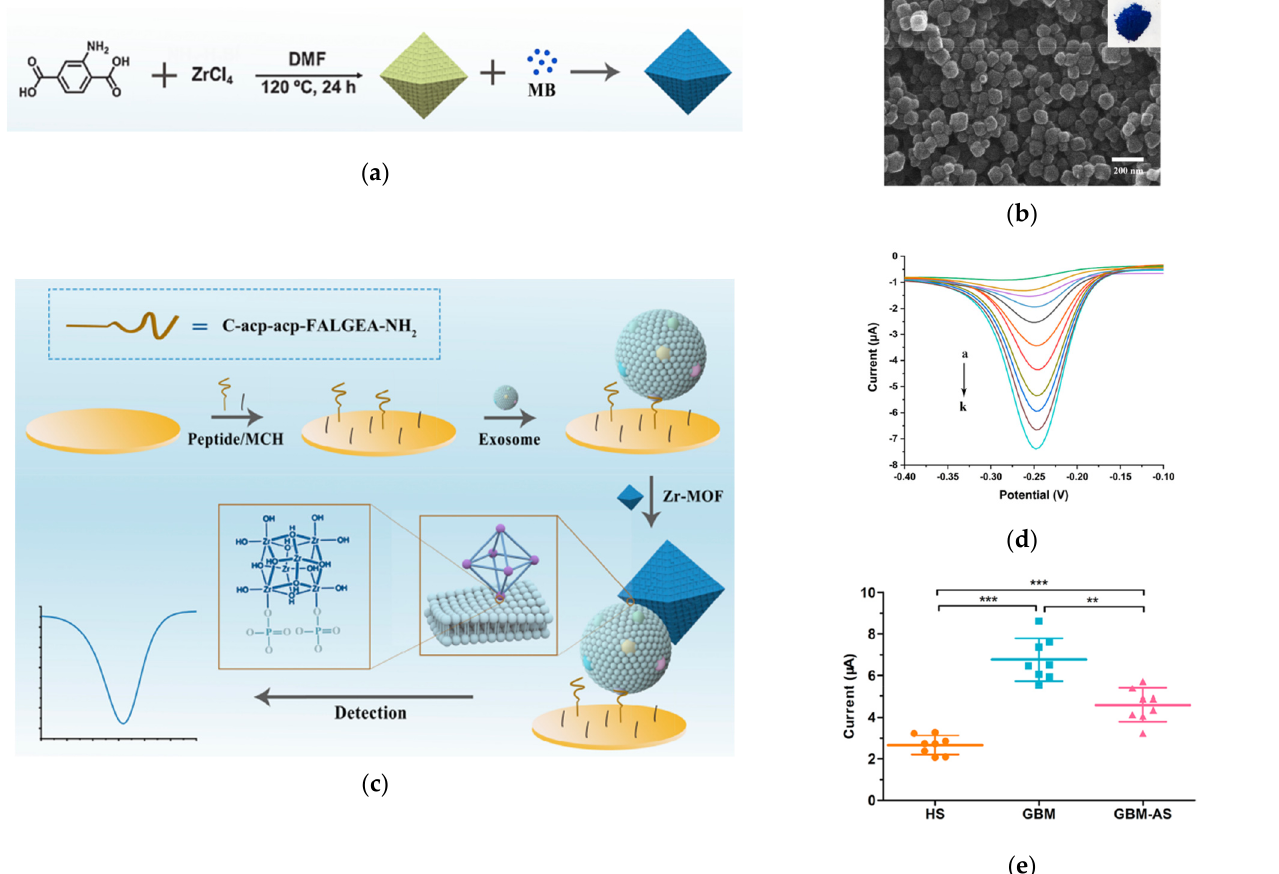
Figure 7. Detection of Glioblastoma-derived exosomes with Zr − based MOFs. ( a ) Schematic of the preparation of MB@UiO − 66 nanoprobes. ( b ) Scanning microscope image of MB@UiO − 66 nano- probes. ( c ) Schematic of the principle of electrochemical detection of exosomes using MB@UiO − 66 nanoprobes. ( d ) SWV recorded with different concentrations of exosomes. ( e ) Scattered dot plots of exosomes from different human subjects. HS: healthy subjects. GBM: Glioblastoma. GBM − AS: GMB after surgery. ***: p < 0.0001. **: p < 0.001. Error bars represent the standard deviation of three inde- pendent experiments. Reprinted with permission from [155]. Copyright (2020) American Chemical Society.